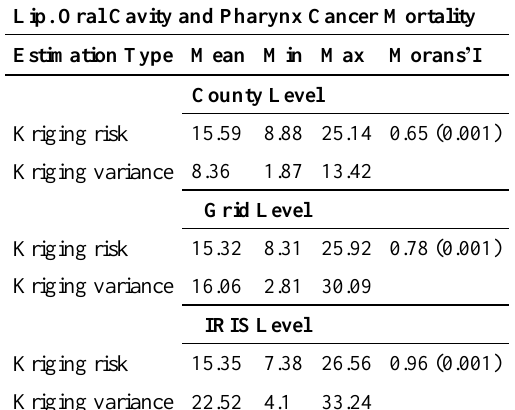
Table 3 . Summary statistics for health indicators after applying Poisson